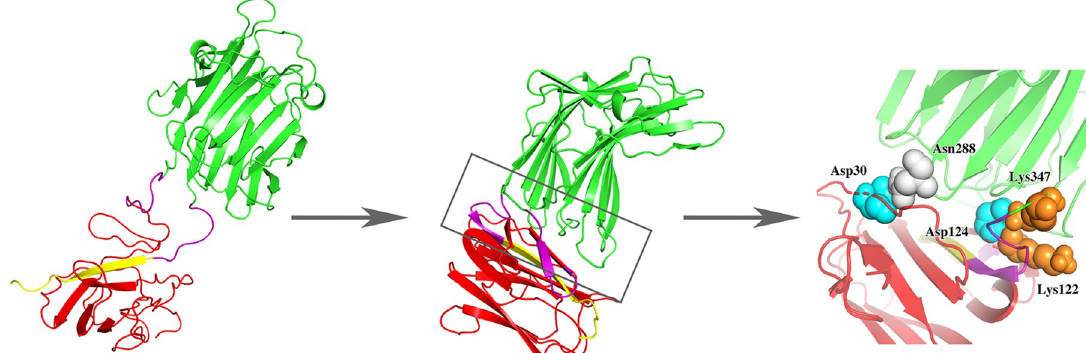
Fig 1. Protein structure of wild type before (left) and after (middle) simulated, where green is lichenase, yellow is SpyTag, and red and magenta are SpyCatcher (magenta highlights the part of SpyCatcher that interacts with the enzyme). The protein interface diagram (right) shows conservative interactions. The following figures apply the same colors to identify the enzyme and SpyCatcher/SpyTag.